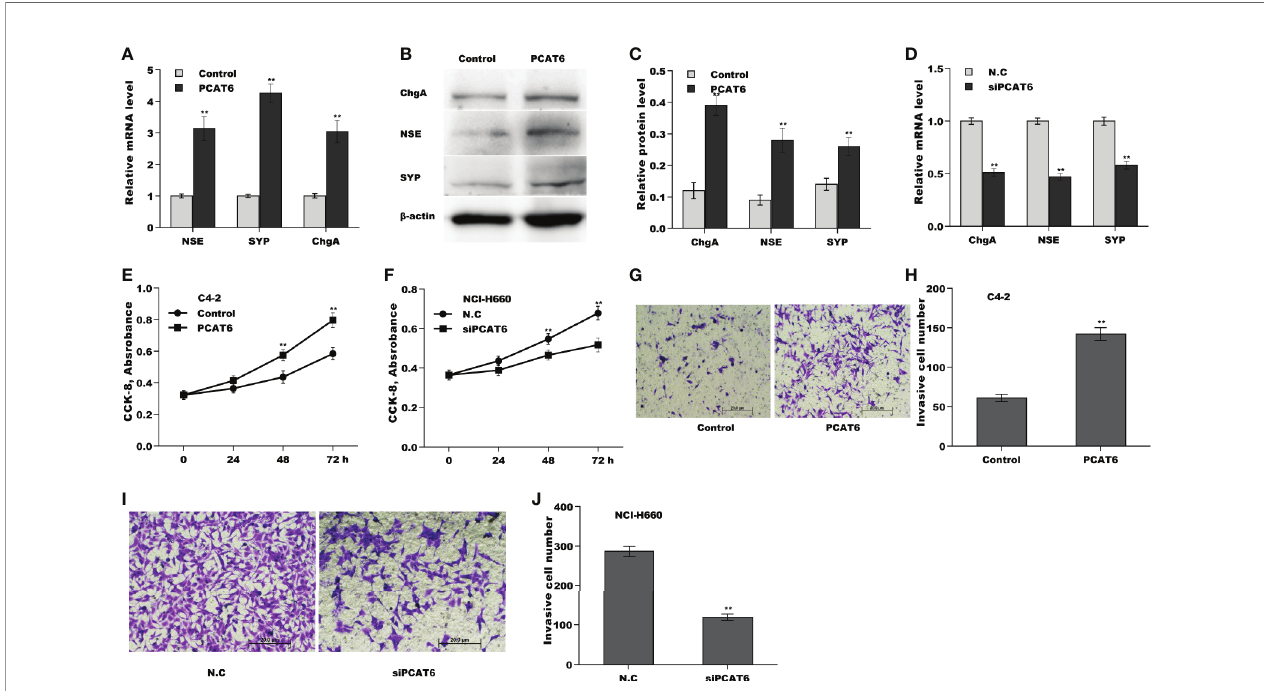
FIGURE 2 | PCAT6 promoted NED, proliferation, and invasion of PCa cells in vitro . (A) qPCR analysis of NE markers (NSE, SYP, and ChgA) mRNA expression in LNCaP cells after PCAT6 overexpression. (B, C) Western blot analysis for NSE, SYP, and ChgA protein level in LNCaP cells after PCAT6 overexpression. (D) qPCR analysis of NSE, SYP, and ChgA mRNA expression in NCI-H660 cells after PCAT6 knockdown. (E) LNCaP cell proliferation was assayed using CCK-8 after PCAT6 overexpression. (F) NCI-H660 cell proliferation was assayed using CCK-8 after PCAT6 knockdown. (G, H) LNCaP cell invasion was assessed using transwell invasion assay after PCAT6 overexpression. (I, J) NCI-H660 cell invasion was assessed using transwell invasion assay after PCAT6 knockdown. * p <0.05. ** p